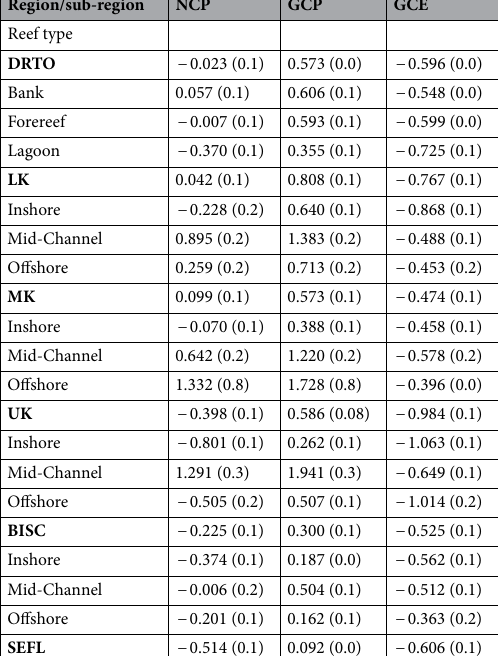
Table 2. A regional/sub-regional comparison of average net carbonate production (NCP), gross carbonate production (GCP) and gross carbonate erosion (GCE) of South Florida reef systems in units of kg CaCO 3 m -2 year −1 (Std. error listed in parentheses). Sub-regions are listed in a southern to northern gradient as follows: DRTO Dry Tortugas; LK Lower Keys; MK Middle Keys; UK Upper Keys; BISC Biscayne; and SEFL Southeast Florida. A reef type comparison was included for DRTO (i.e., bank, forereef, lagoon) and the FLK region (i.e., inshore, mid-channel, offshore), with the exception of SEFL where reef type classification was